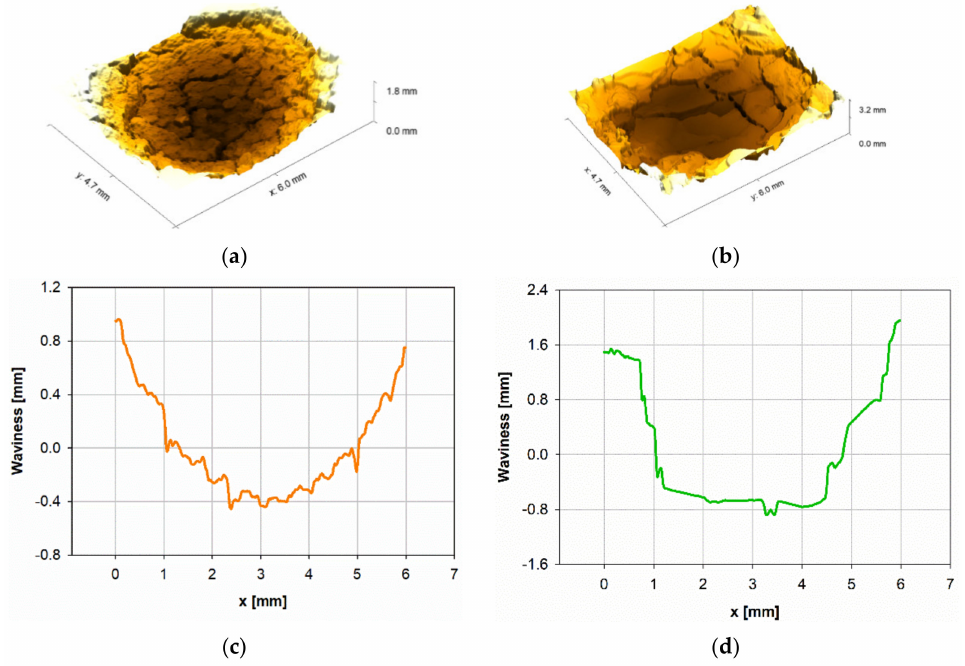
Figure 11. Three-dimensional topography of the ( a ) the SiR + 30 wt% GS10 and ( b ) SiR + 5 wt% FS07 composites tested using the dry-arc resistance test. Corresponding waviness profiles for ( c ) SiR + 30 wt% GS10 and ( d ) SiR + 5 wt% FS07